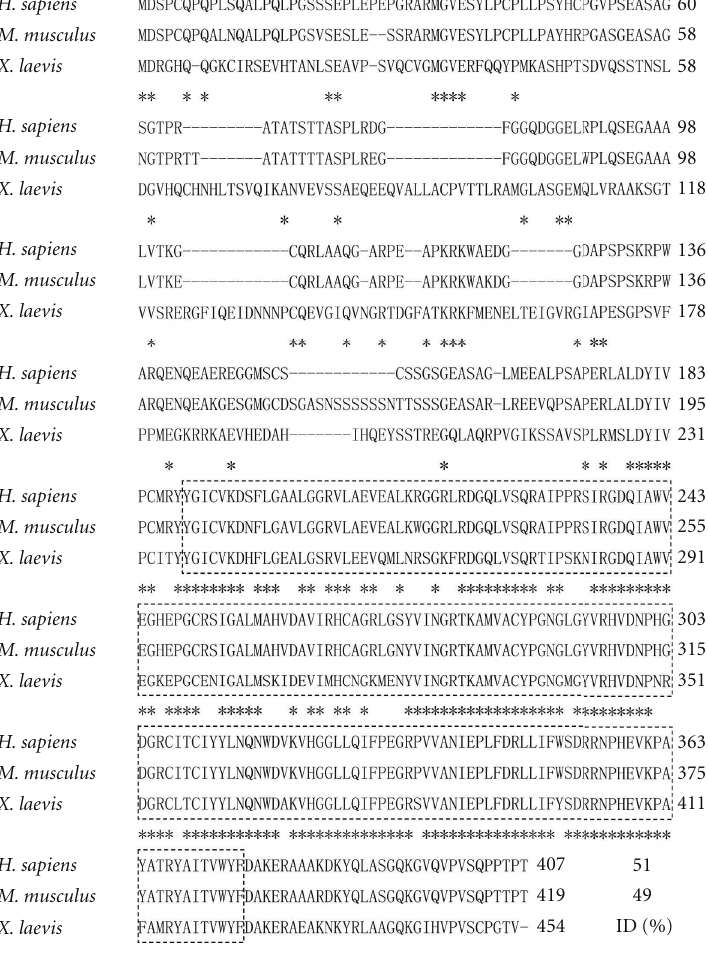
Figure 1: Predicted primary sequence of Xenopus phd1 in comparison with human and mouse Phd1 . Stars indicate identical amino acids in all three species. Hyphens represent gaps introduced for optimizing the alignment. Dashed rectangles demarcate the highly conserved prolyl 4 hydroxylase domain. ID stands for the percentage of amino acid identity of Xenopus laevis phd1 in comparison with human and mouse Phd1